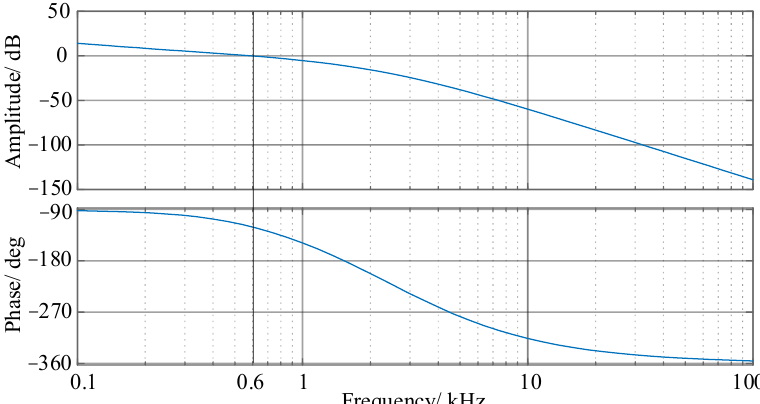
Figure 13. Bode plot of rotor flux open loop.